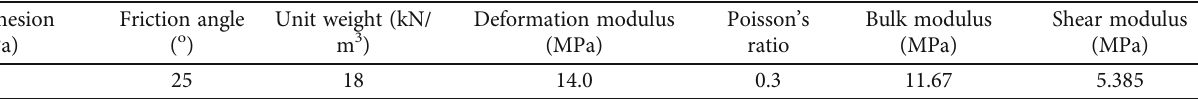
Table 1: Calculation parameters of site soil mass.